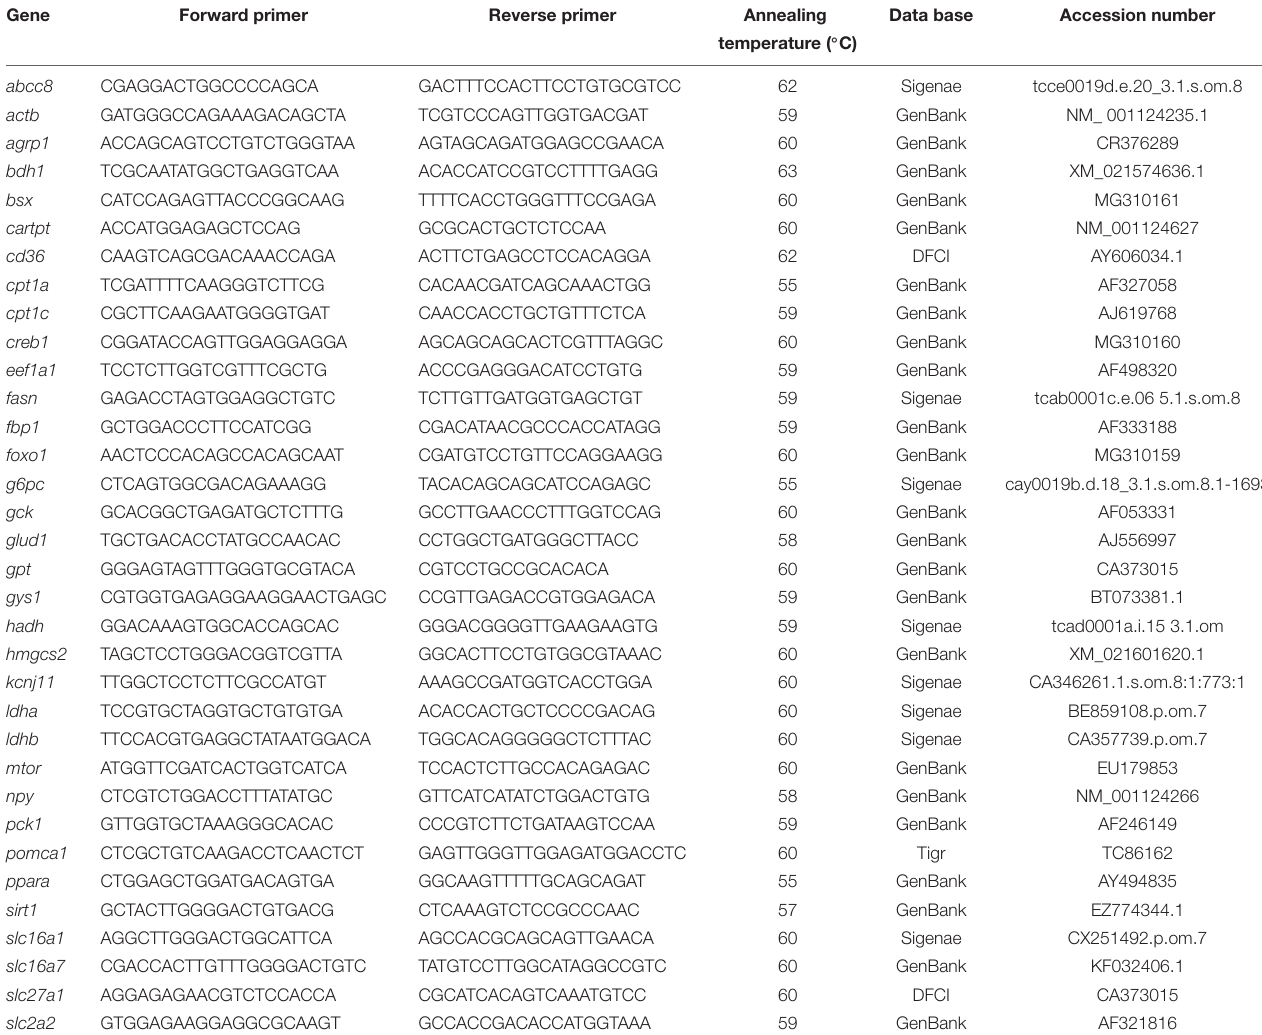
TABLE 1 | Nucleotide sequences of the PCR primers used to evaluate mRNA abundance by RT-PCR (qPCR). Gene Forward primer Reverse